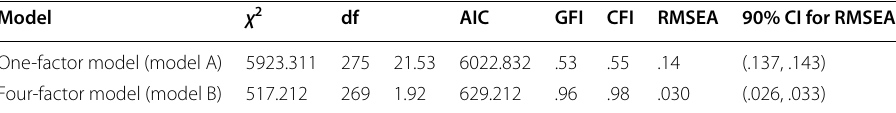
Table 2 Summary of model fit statistics for the one-factor and four-factor models